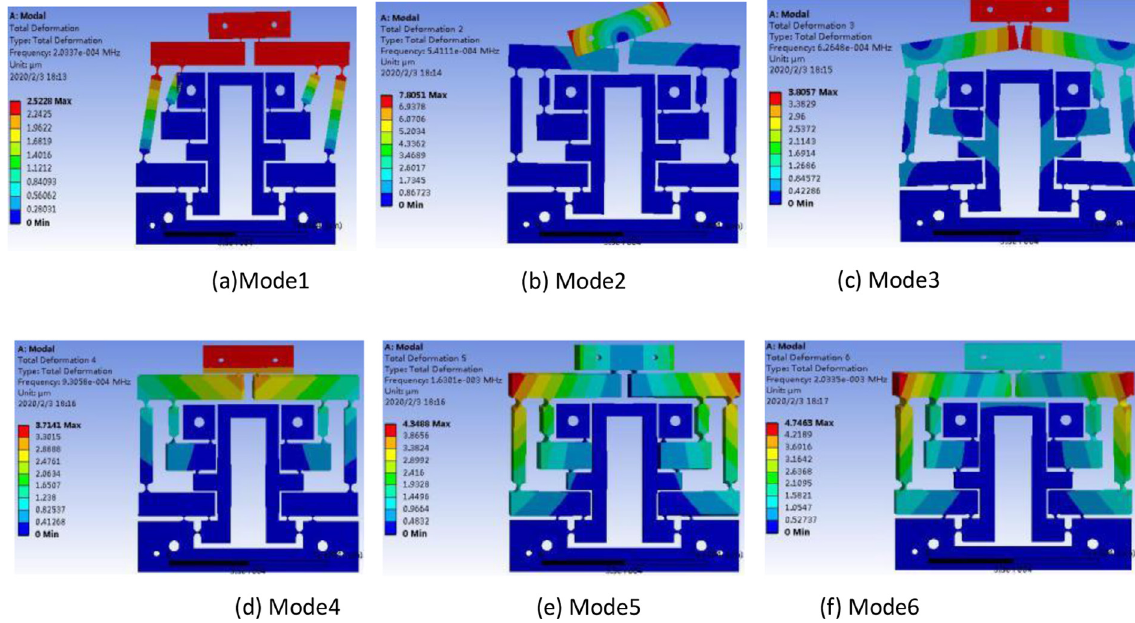
Fig. 9. The fi rst six mode shapes of the mechanism.